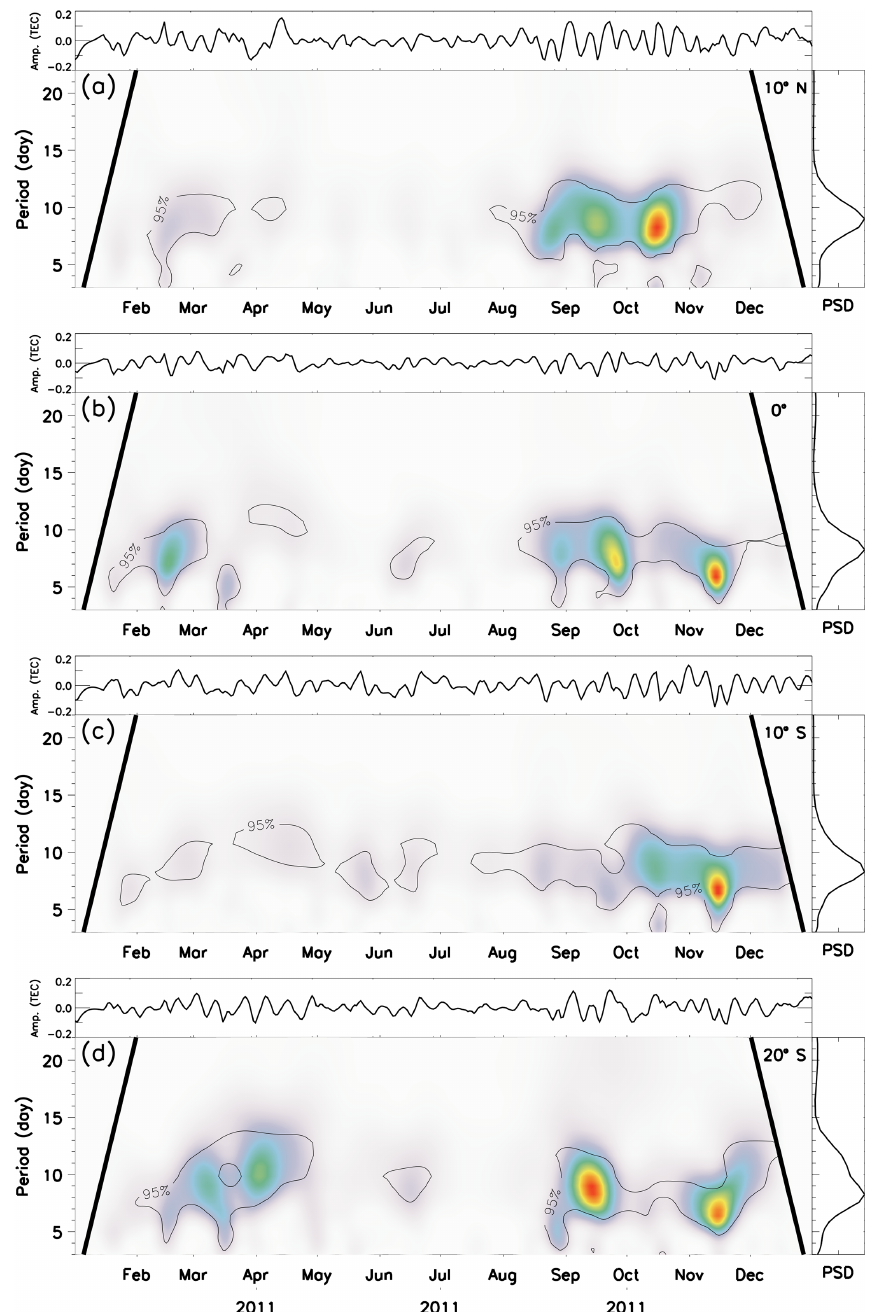
Figure 6. Same as Fig. 3 but considering only periods shorter than 25d during